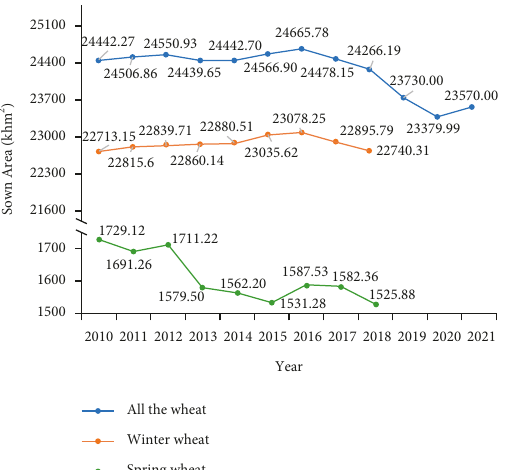
Figure 3: The sown area of wheat in China from 2010 to 2021. The sown area data of winter and spring wheat in 2019–2021 was with no records in the website of National Bureau of Statistics of China